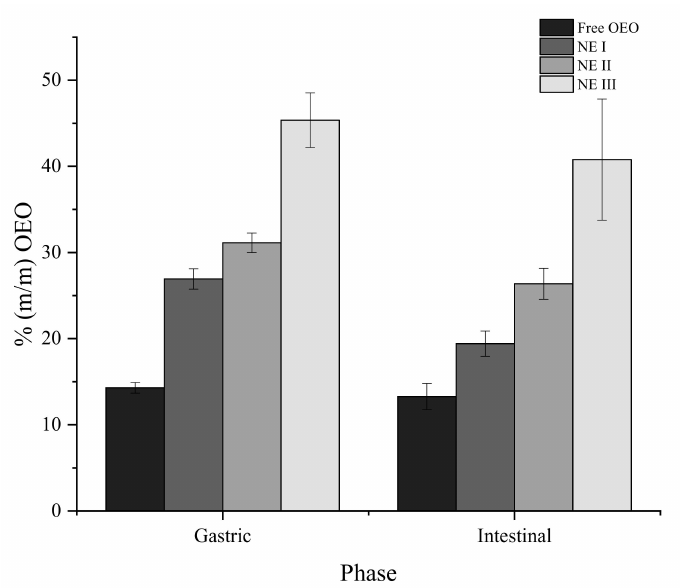
Figure 6. OEO (% m/m) present in the gastric and intestinal phases after the simulated digestion of NE I, II, and III and free OEO. p -values of 3.23 × 10 − 4 and 1.77 × 10 − 4 for the gastric and intestinal phases,